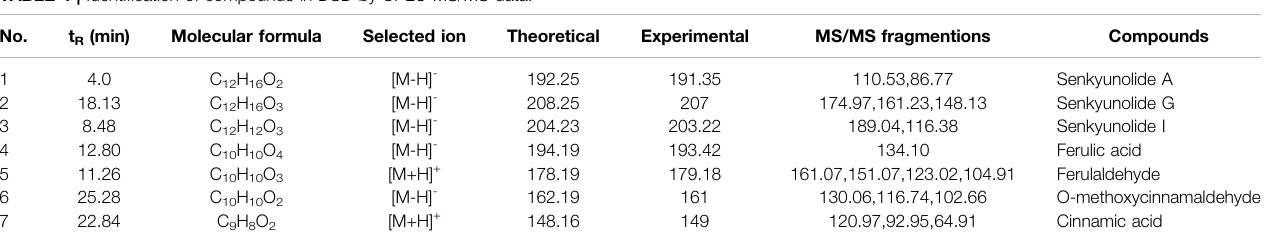
TABLE 4 | Identi fi cation of compounds in DSD by UPLC-MS/MS data.